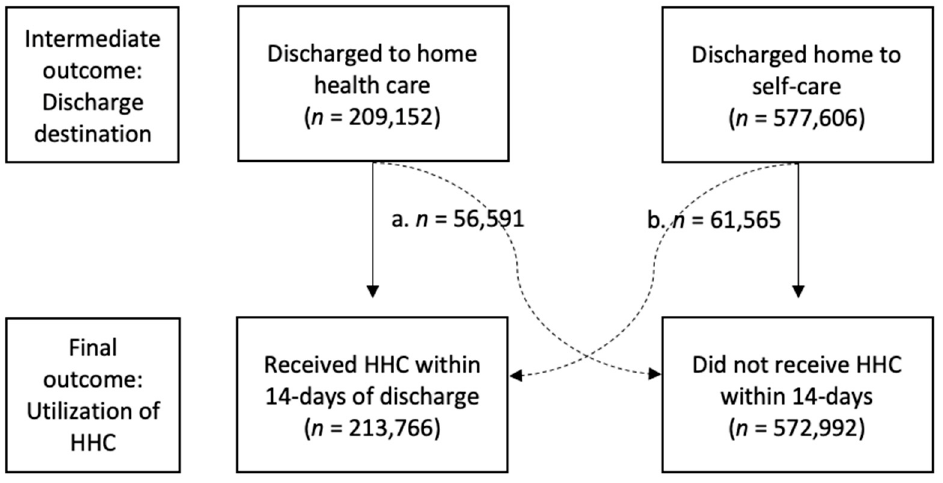
Figure 2. Discharge destination and 14-day home health care (HHC) utilization outcomes for sample ( n = 786,758). Note: Solid lines represent expected patterns; dashed lines represent unexpected patterns. ( a ) 56,152 (27%) patients who were discharged to HHC did not receive services. ( b )